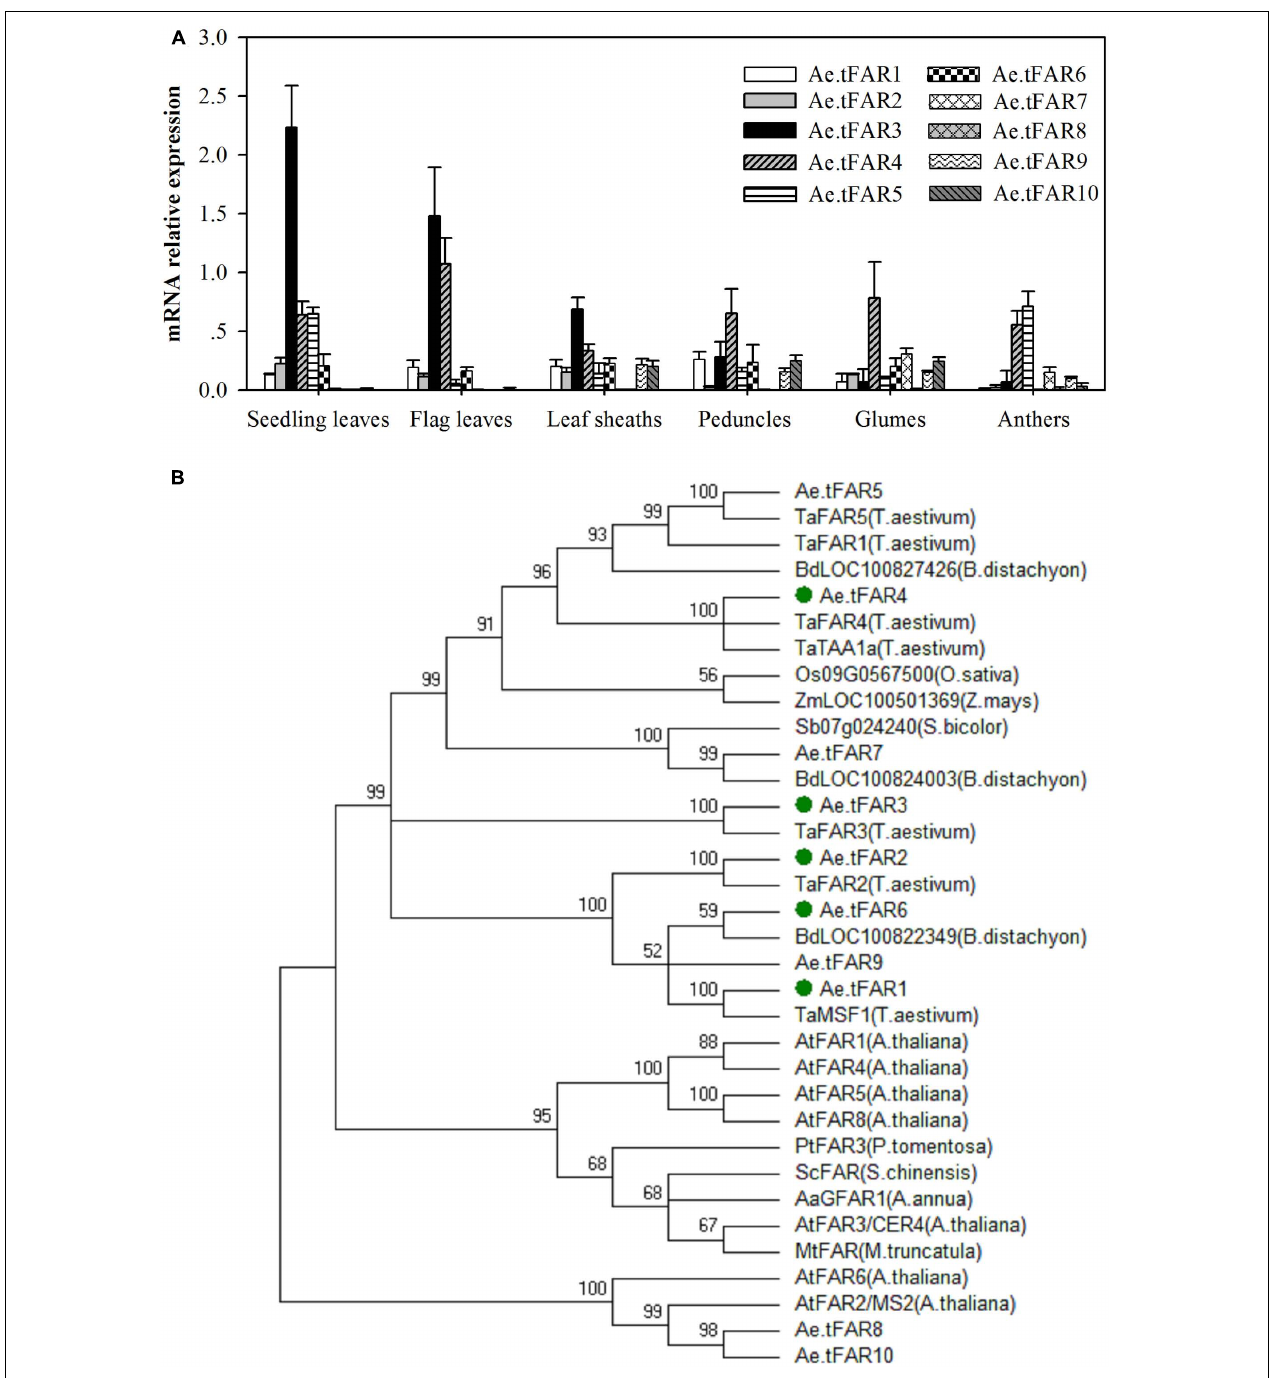
FIGURE 3 | Gene expression and phylogenetic analysis of Ae.tFAR. (A) Tissue-specific gene expression patterns of Ae.tFAR by quantitative real-time PCR (qRT-PCR). Each value is the mean of three biological replicates. Error bars = SD. (B) Phylogenetic tree of the alcohol-forming fatty acyl-CoA reductases (FARs) from different species. The GenBank accession numbers of the FAR sequences from different plant species are summarized in Supplementary Table